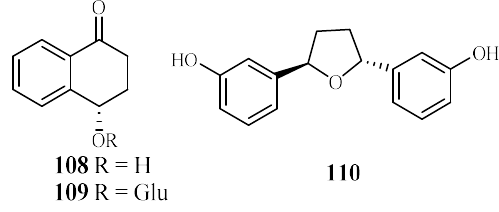
Figure 22. Compounds from Lythraceae plants.